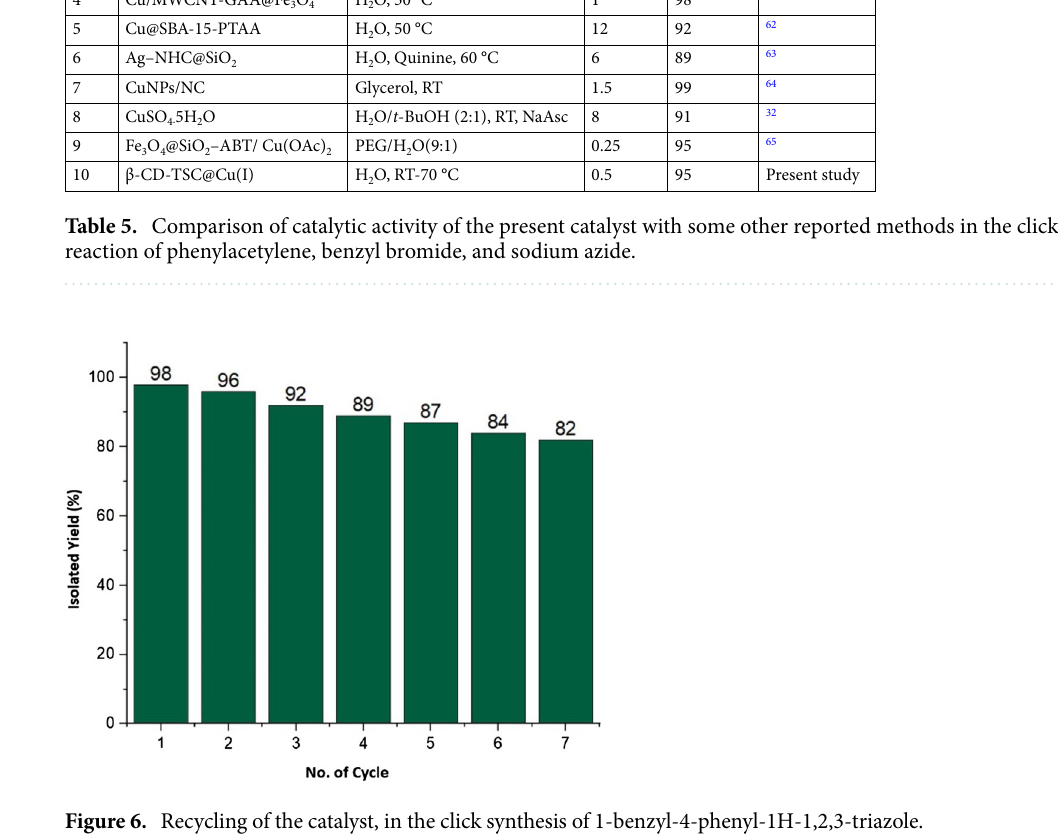
Figure 6. Recycling of the catalyst, in the click synthesis of